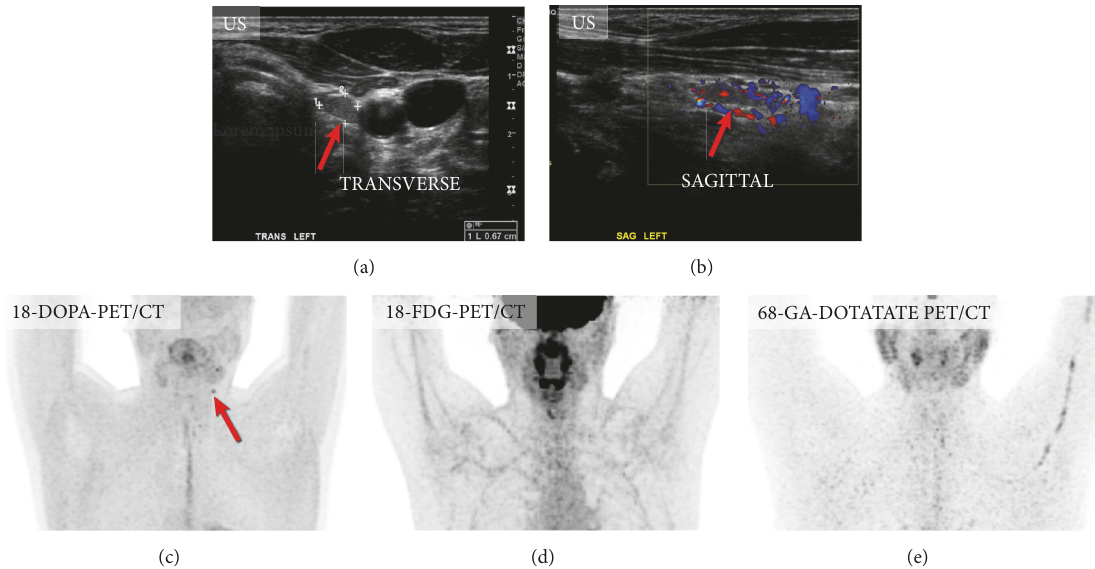
Figure 6: Mapping of the metastatic lymph nodes in medullary thyroid carcinoma. Asymptomatic patient after thyroidectomy for medullary thyroid carcinoma and elevated calcitonin level (54 pg/ml) was evaluated for possible neck lymph node metastases. Ultrasound of the neck showed several suspicious lymph nodes (not shown). One of the lymph nodes (b) was found to be positive on only 18F-FDOPA-PET/CT (c), while 18F-FDG-PET/CT and 68Ga-DOTATATE-PET/CT were